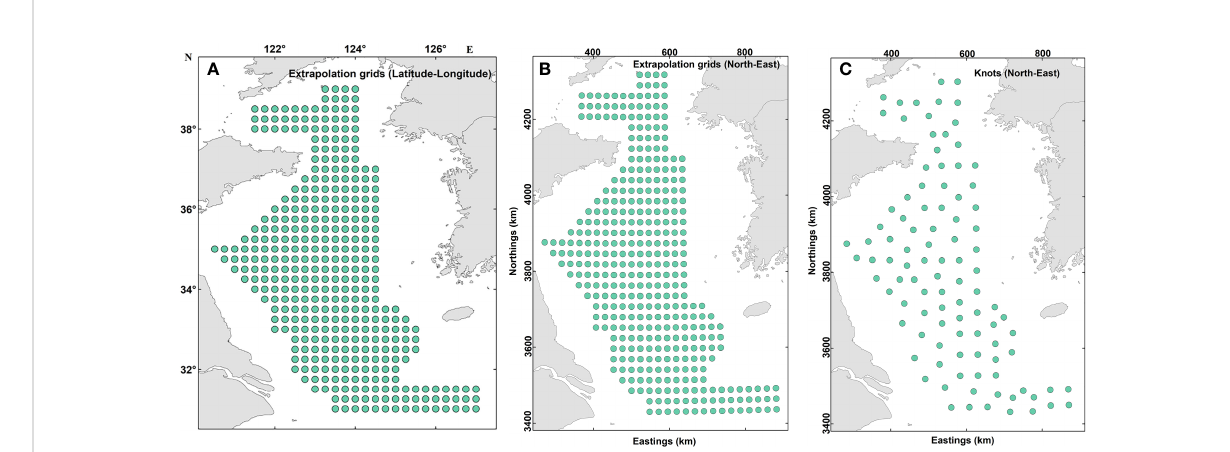
FIGURE 2 Maps showing the barycenter of extrapolation grid cells and of the “ knots ” used within the spatio-temporal models. The extrapolation grid consists of 375 cells and the locations are shown in latitude-longitude using the World Geodetic System 1984 (A) and northings-eastings using Universal Transverse Mercator projection (B) . For computational ef fi ciency, 100 “ knots ” was speci fi ed to approximate the variation terms of the spatio-temporal models developed and the locations of these knots are shown in (C)